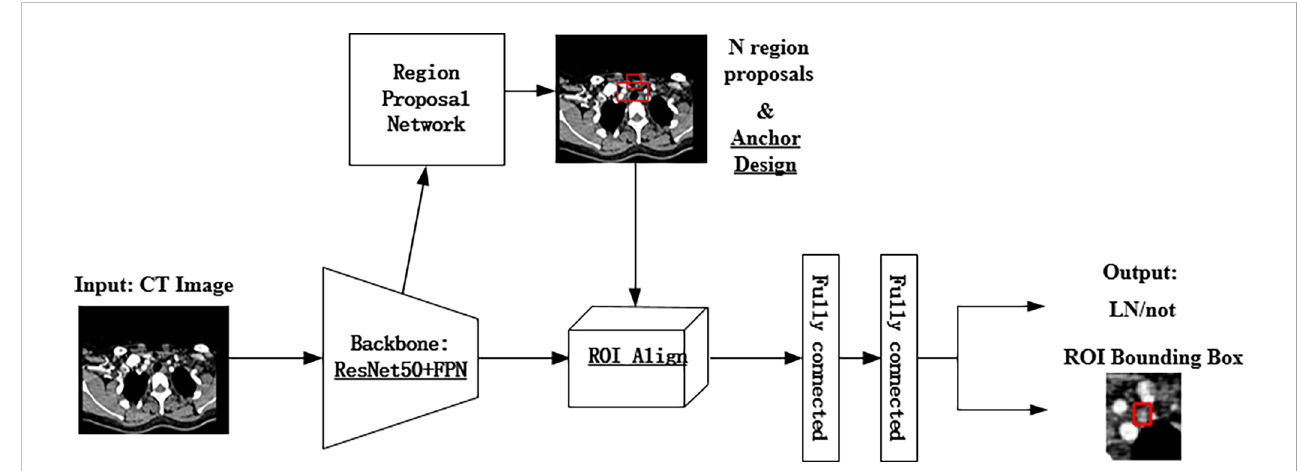
FIGURE 4 The pipeline of the improved Faster